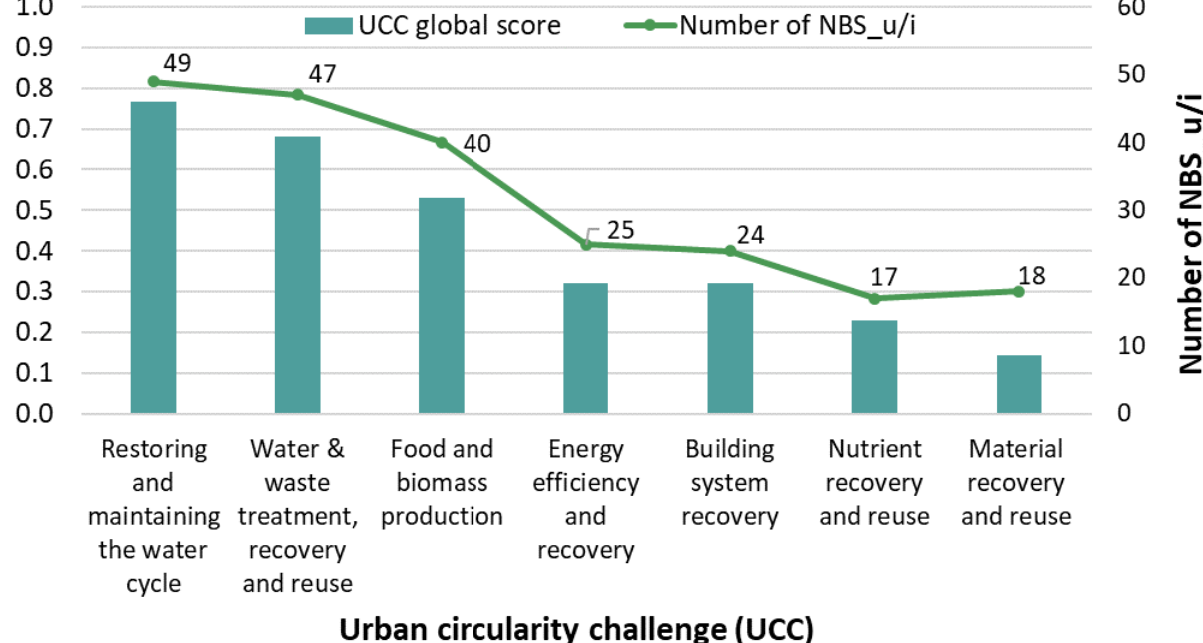
Figure 4. NBS global scores for UCC (colored bars) and number of UCC addressed per each NBS_u/i (gray line). Obs: The bars are colored as a function of pre-established sub-categories.